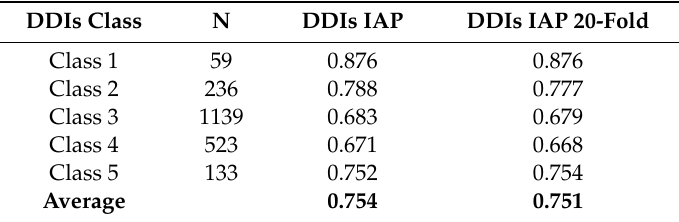
Table 1. Accuracy of the ORCA DDIs classes prediction estimated by the LOO CV and 20-fold CV